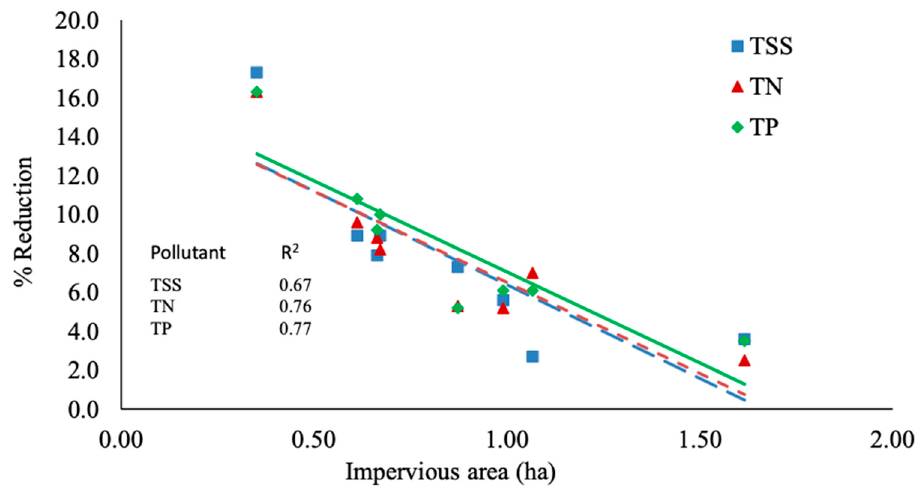
Figure 11. The relationship between pollutant reduction and contributing impervious area. The figure also indicates the correlation for TSS, TN, and TP with increasing contributing area. The pollutant reduction decreased with increased contributing impervious area.